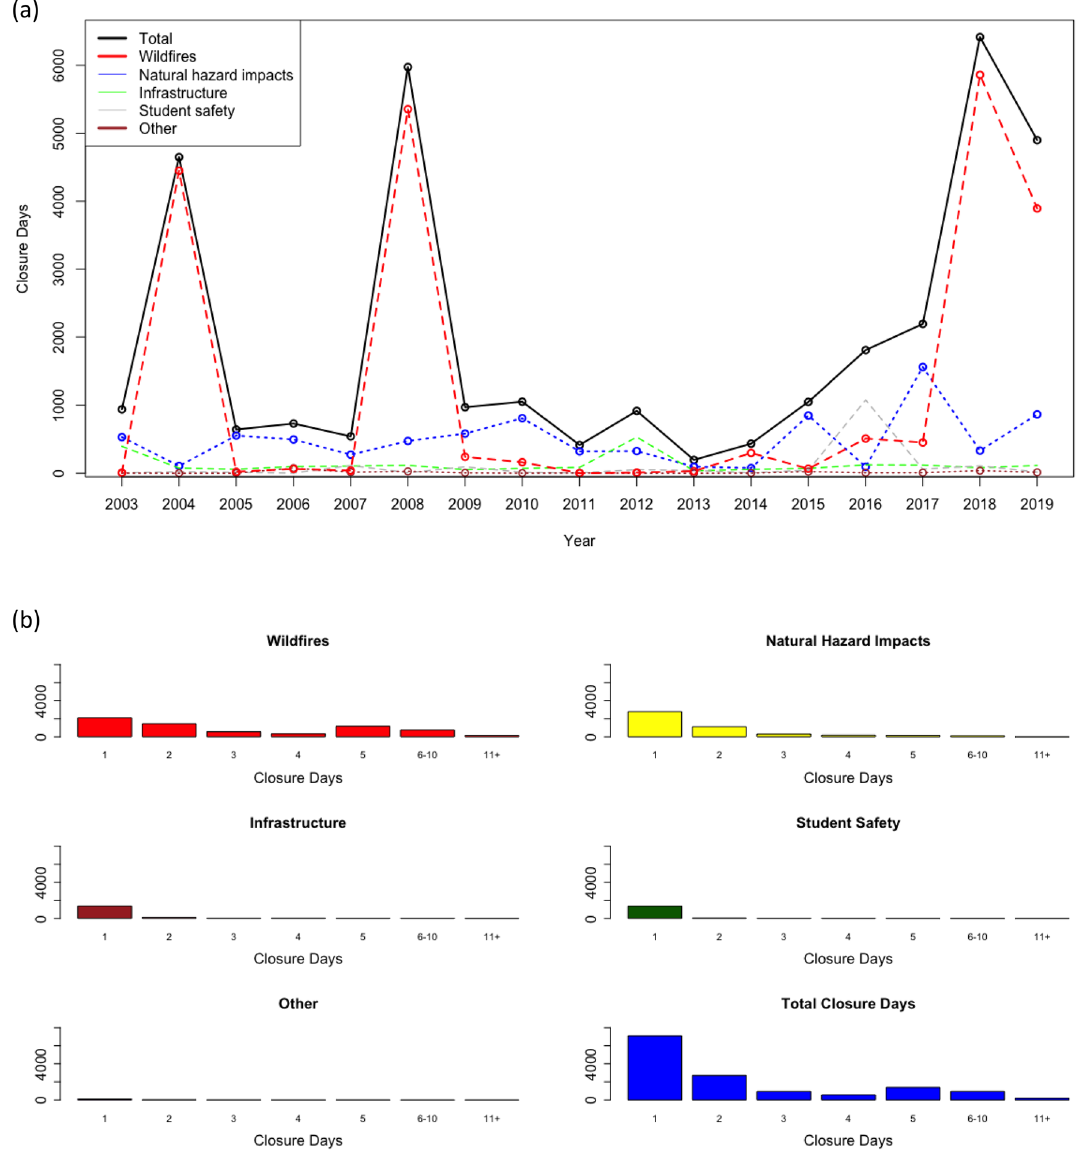
Figure 1. School closure days by cause. ( a ) Total school closure days across academic years ending in 2003– 2019. ( b ) Histograms of frequency of school closure days by length of wide closures, closures lasted an average of 2.44 days, though wildfire-caused school closures lasted an average of 3.28 days (Fig. 1b). Wildfires were responsible for the vast majority of closures during the four academic years with more than 2500 total closure days (range: 3893 days in 2018–2019, 79.5%; 5860 days in 2017–2018, 91.3%). The vast majority of schools (70.9%) close for no more than 2 days, with only 1136 (8.2%) schools closing for more than 5 days. Wildfires caused 80.5% (915) of the closures lasting more than 5 days and 86.1% of the school closures (162 of 188 closures) lasting more than 10 days. In addition, 12,699 (91.8%) of total closures are short- term and last up to 1 week (1–5 days), 948 (6.9%) are medium-term and last between 1 and 2 weeks (6–10 days), and 188 (1.4%) are long-term and last more than 2 weeks (11 + days). Based on data collected by CalMatters, 78.0% of school closure days (26,384 days) occurred in the fall semester and 22.0% (7435 days) occurred in the spring semester (Table 1). Wildfires were the primary cause of school closure days during the fall semester, accounting for 20,861 (79.1%) fall closure days. Natural hazard impacts were the primary cause of school closure days during the spring semester, accounting for 5615 (75.5%) spring closure days. Wildfires are also the biggest cause of missed student-days, referring to the cumulative number of school closures multiplied by the number of students enrolled at the affected schools. Between the 2002–2003 and 2018–2019 academic years, school closures resulted in 18,623,056 cumulative missed student-days, of which wildfires were responsible for 13,491,539 (72.4%) student-days (Table 1).